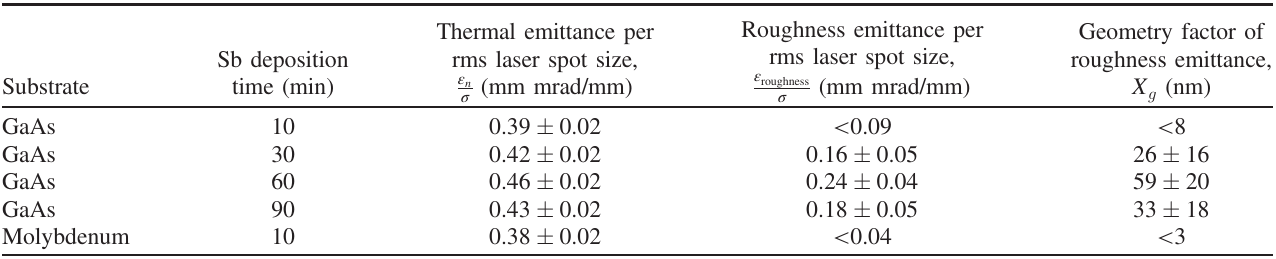
TABLE II. Thermal emittance, roughness emittance and geometry factor values for the tested photocathode samples.